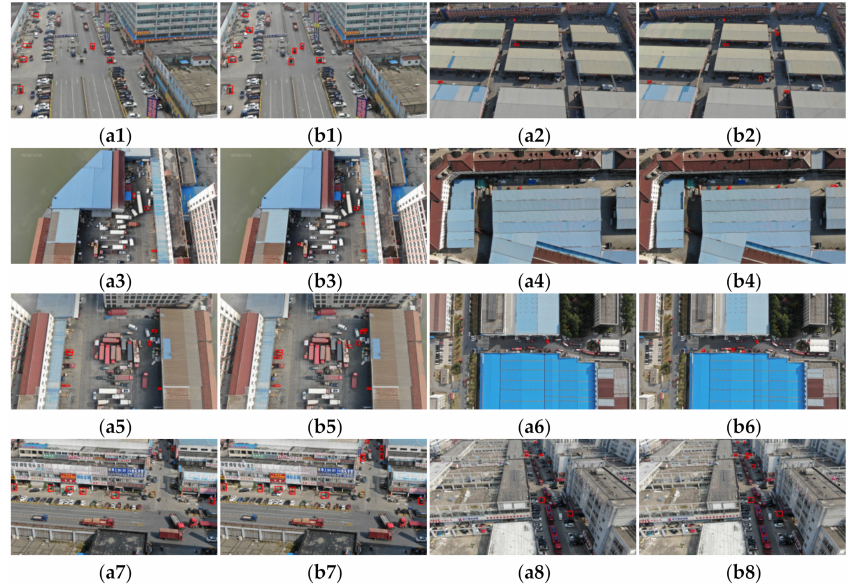
Figure 10. Detection results on the forklift dataset: ( a1 – a8 ) and ( b1 – b8 ) are the detection results of YOLOv4 and our proposed method,